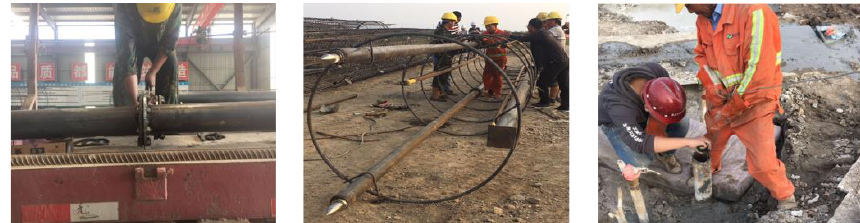
Figure 7. Dynamic penetration test.